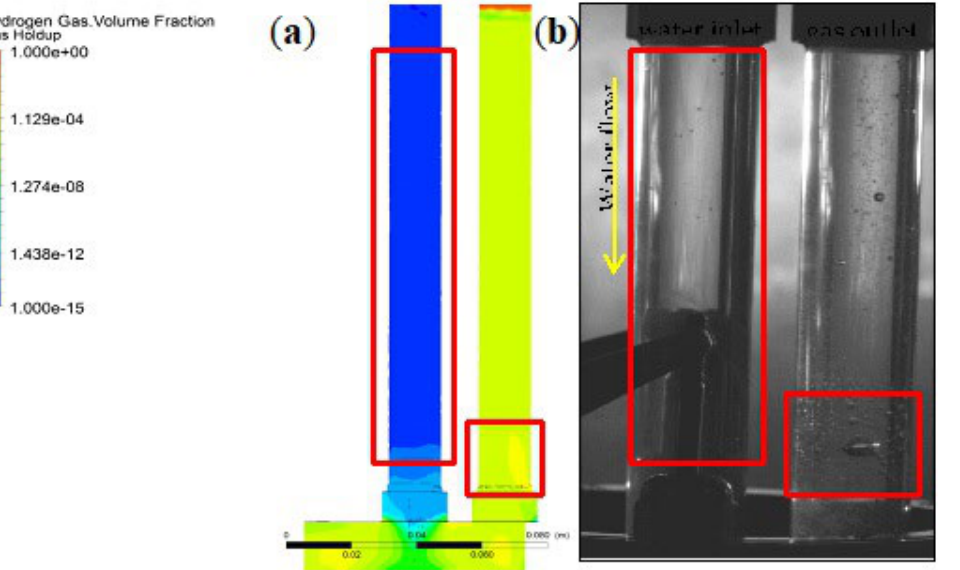
Figure 6. Qualitative visual comparison of bubble accumulation in the simulation ( a ) and the experiment ( b ).